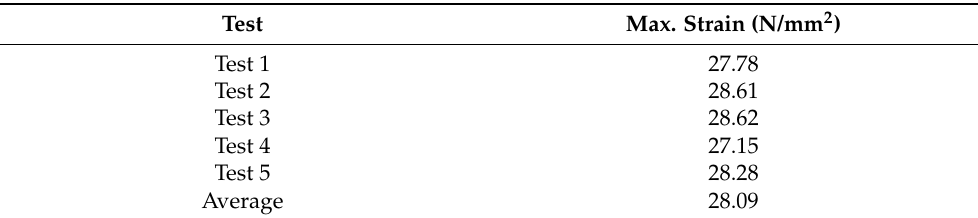
Figure 6. A crack appeared in the top area of the mold insert, near the upper feeding channel. Table 7. Consolidated results of the tensile test on polypropylene specimens obtained in a 3D printed resin mold insert.